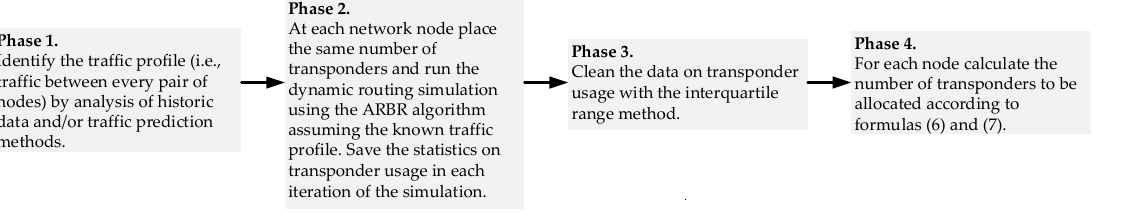
Figure 3. Workflow of the scaled average used regenerators (SAUR) method. Appl. Sci. 2020 , 10 , x FOR PEER REVIEW